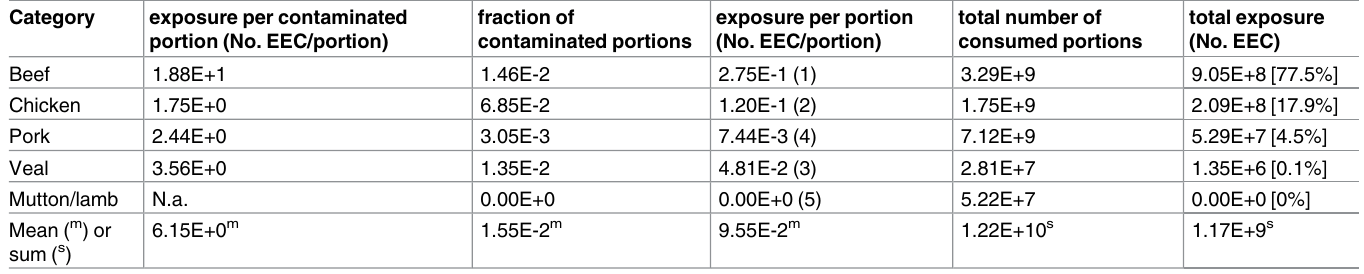
Table 7. Contribution of food animals to the exposure of humans to EEC through meat at the moment of consumption. Category exposure per contaminated fraction of exposure per portion portion (No. EEC/portion) contaminated portions (No. EEC/portion)